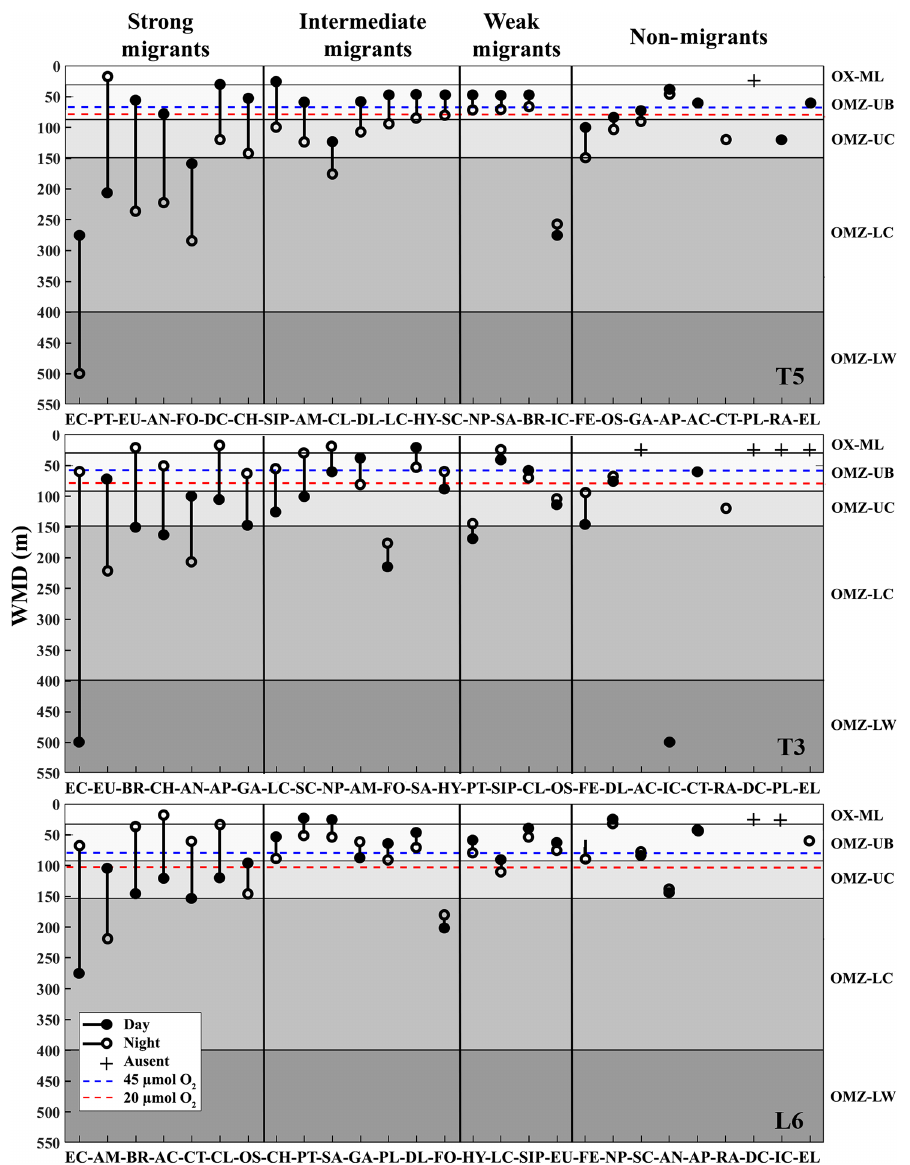
Figure 3. Weighed mean depth distribution (WMD) of the zooplankton community interacting with the OMZ off Iquique (Stations T5 and T3) and off Coquimbo (Station L6) at the northern upwelling area of Chile during the austral spring 2015. Shaded gray areas represent different layers defined by their oxygen levels (defined in Methods). The taxonomic groups were classified by automated analysis (ZooScan): EC is eucalanid copepods, AM is amphipods, BR is Bryozoa larvae, AC is Acartia copepods, CT is ctenophores, CL is Cirripedia larvae, OS is ostracods, CH is chaetognaths, PT is pteropods, SA is salps, GA is gastropods, PL is Platyhelminthes, DL is Decapoda larvae, FO is Foraminifera, HY is Hydrozoa, LC is large copepods, SIP is siphonophores, EU is euphausiids, FE = fish eggs, NP is nauplii, SC is small copepods, AN is annelids, AP is Appendicularia, RA is radiolarian, DC is decapods, IC = ichthyoplankton, EL = echinoderm